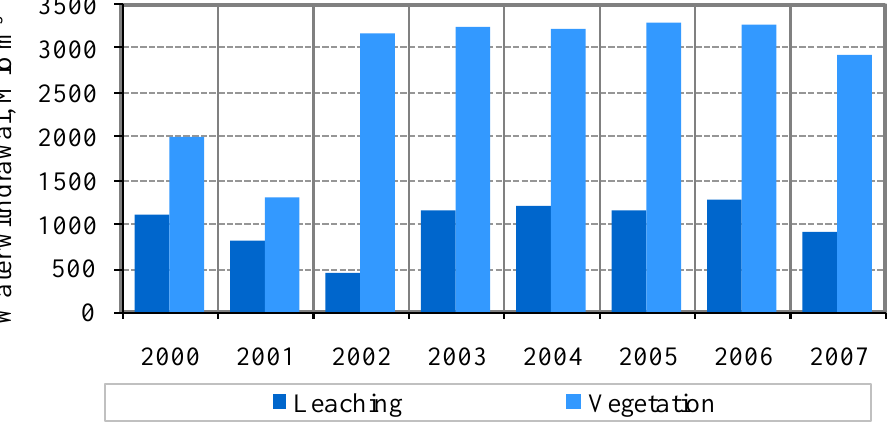
Figure 6. Annual water intake from the Amu Darya for irrigation and leaching,